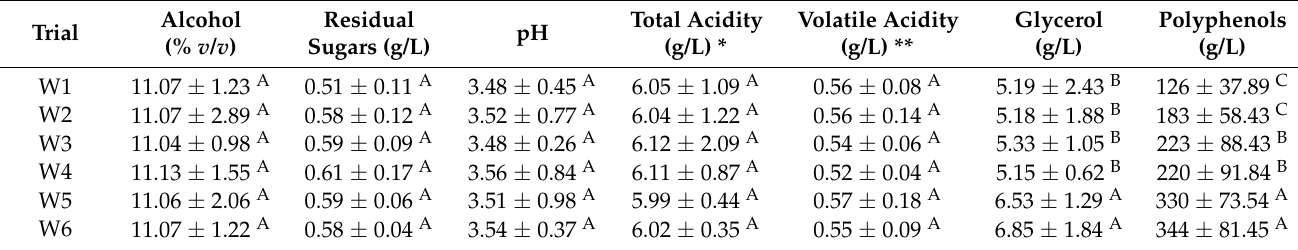
Table 2. Main oenological parameters of obtained